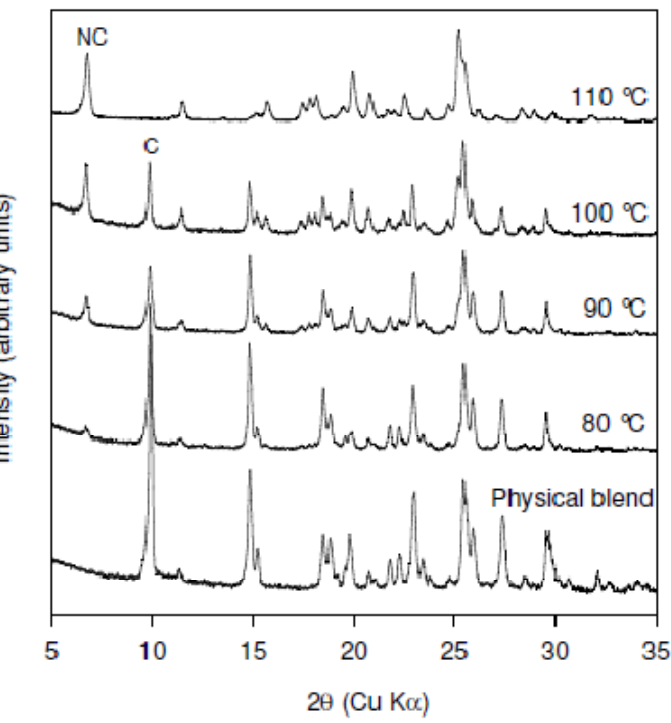
Figure 7. XRPD patterns of materials produced from extrusion of Nicotinamide-trans cinnamic acid blend at 80, 90, 100, and 110 °C at 75 RPM screw speed. The peak corresponding to Cinnamic acid is labeled ‘C’ while the peak corresponding to the cocrystal is labeled as “NC”. The data shows that extent of cocrystal formation is the highest at 110